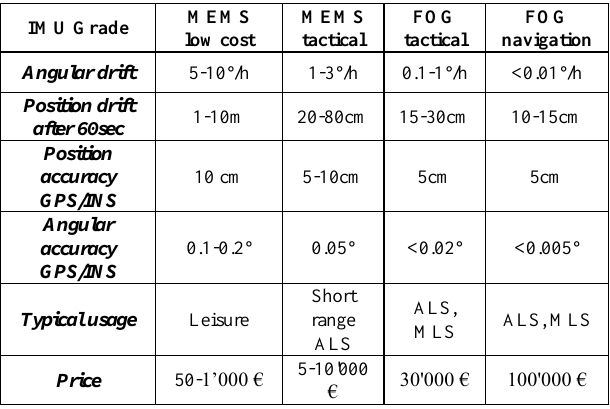
Table 1: Different types of IMU, their accuracies and